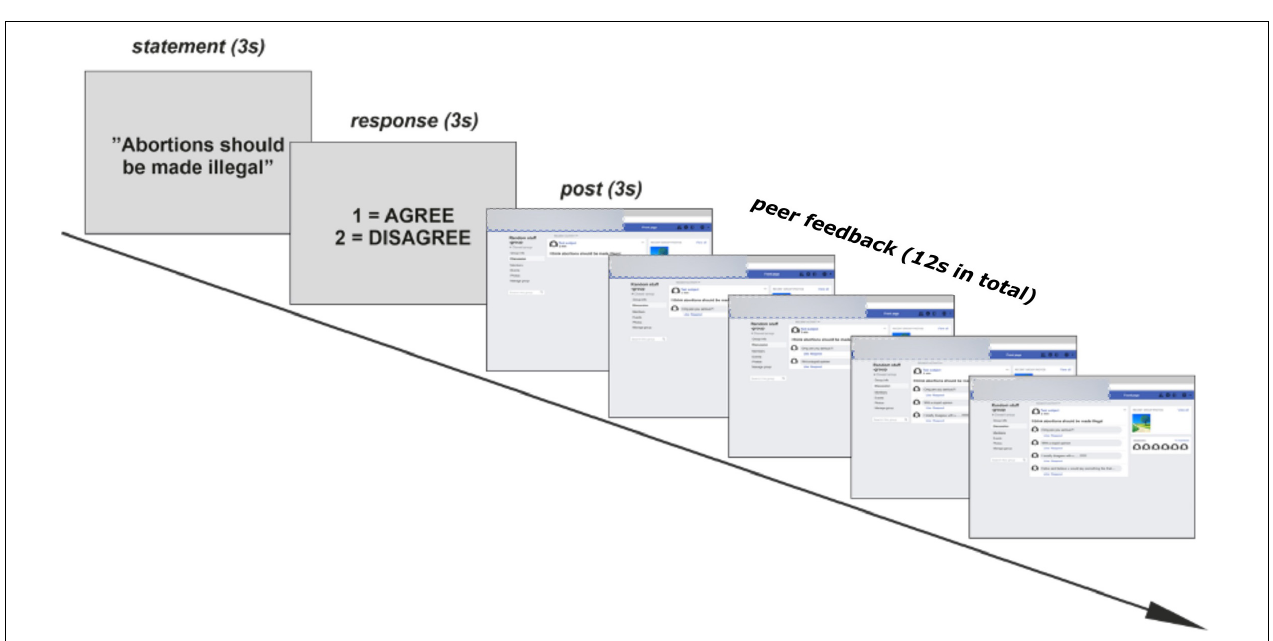
FIGURE 2 | A schematic illustration (translated from Finnish to English) of the procedure of the study. In the sequence of an example trial, where the participants are presented with a controversial statement, they respond with “agree,” and then receive negative peer feedback from peers.